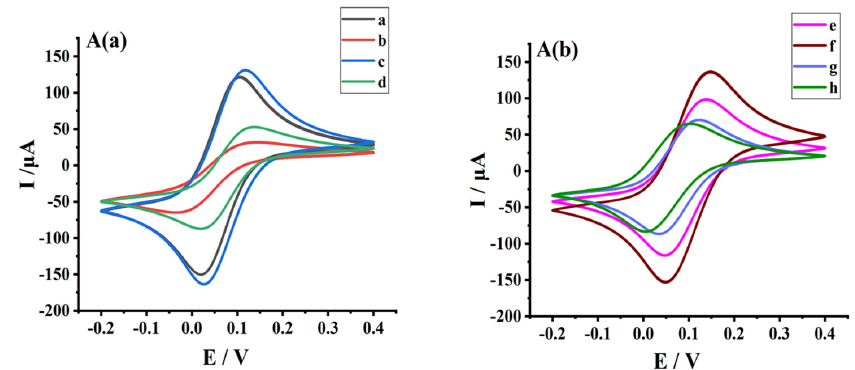
Figure 4. The cyclic voltammetry characterization of the sensor assembly process. The sensor